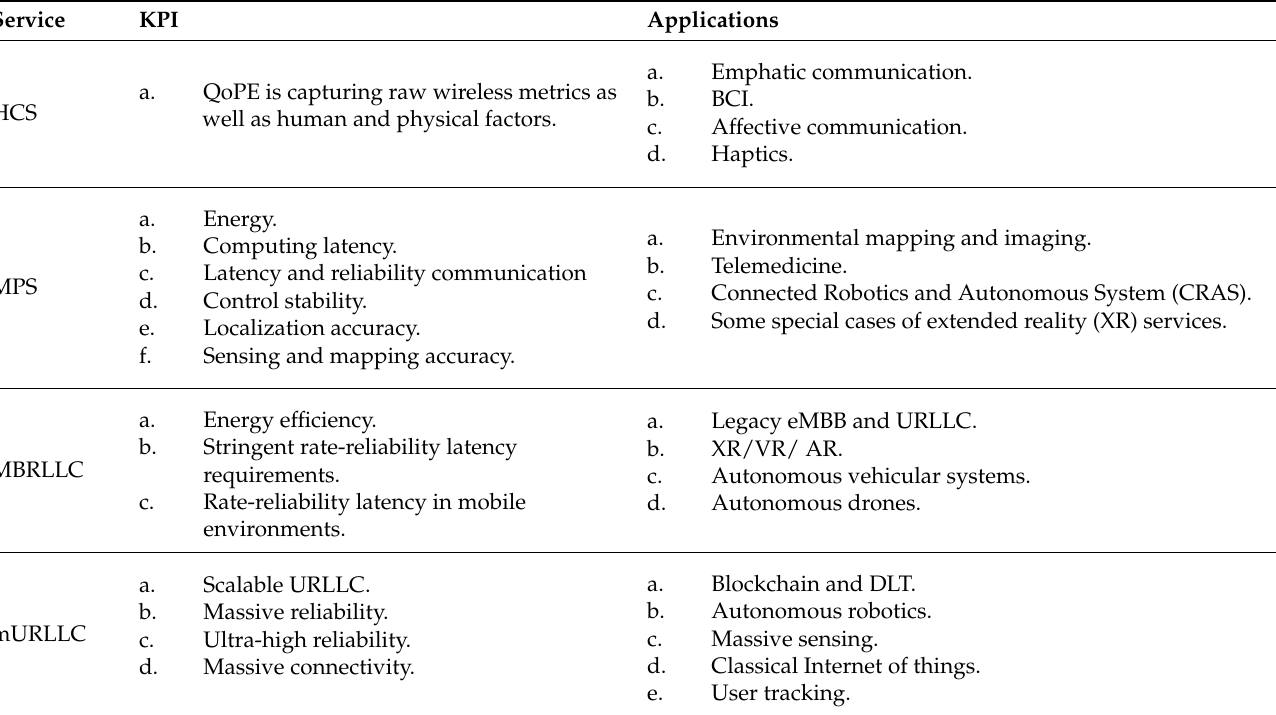
Table 5. Services, Key Performance Indicators (KPIs), and Applications of